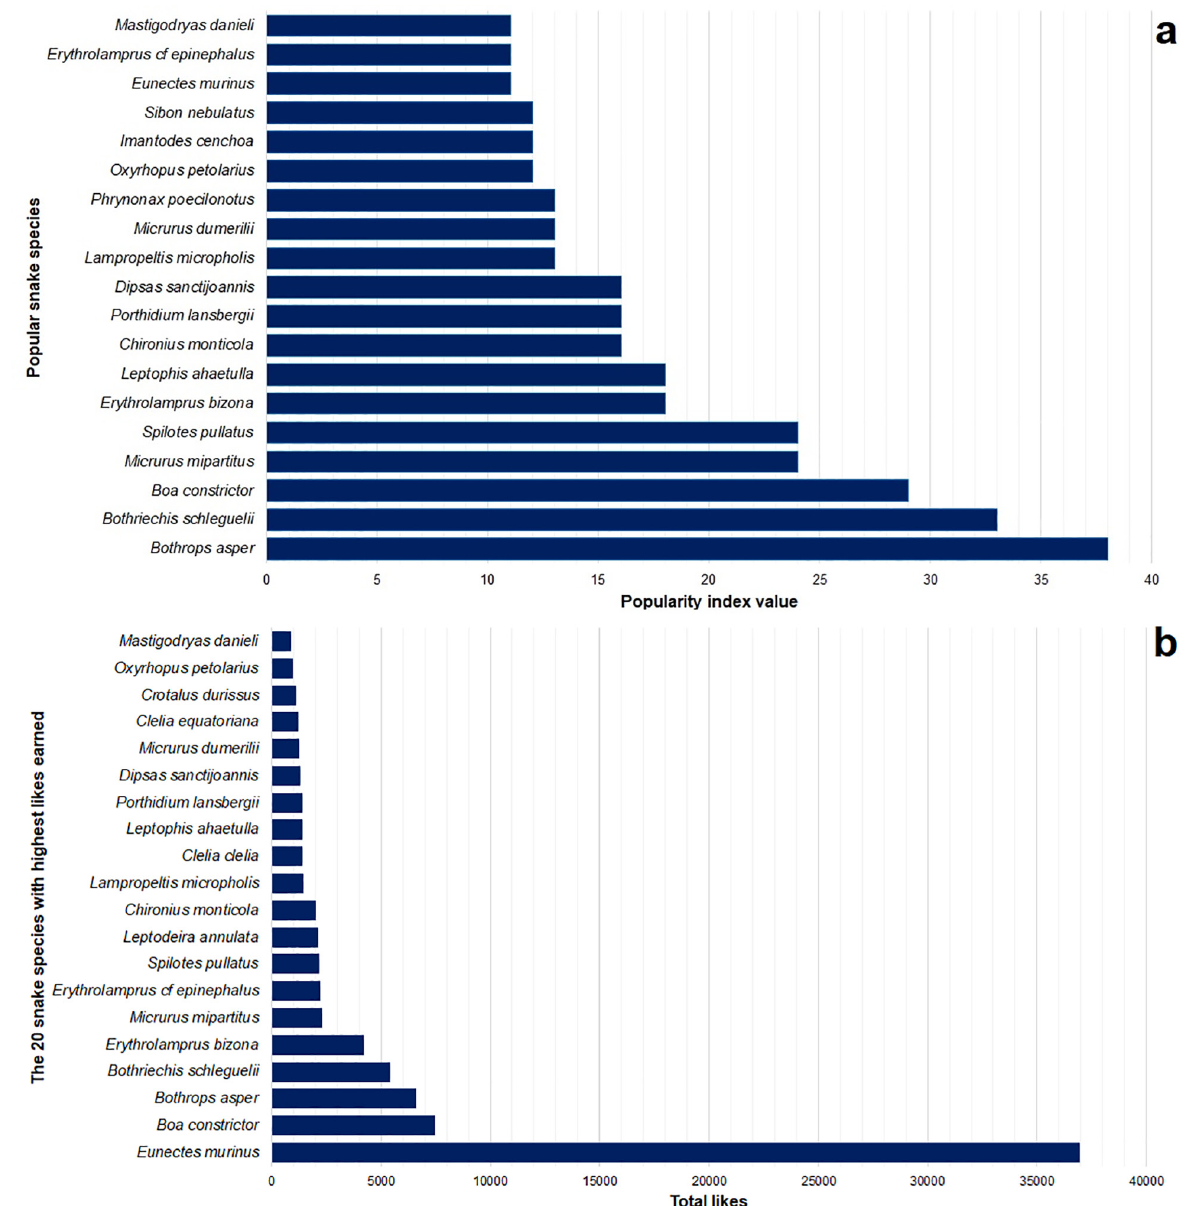
Figure 6. The most popular snake species according to the Colombian Facebook community engaged in snake advocacy. (a) Bar plot showing snake species with an index of popularity >10. (b) Bar plot showing the 20 snake species that received the greatest number of